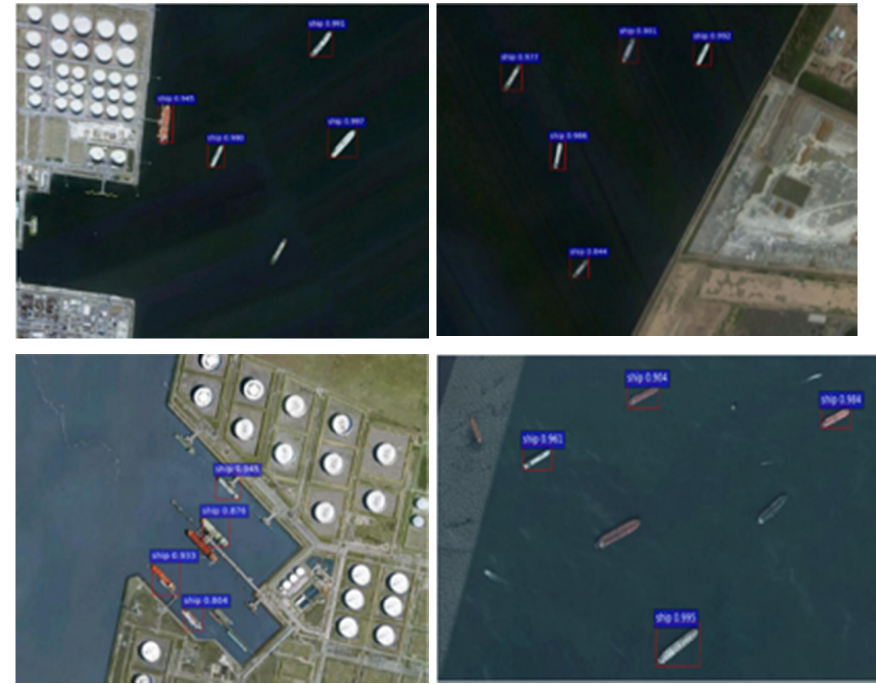
Figure 5. The results of some detected objects from SAR-ship-Dataset.